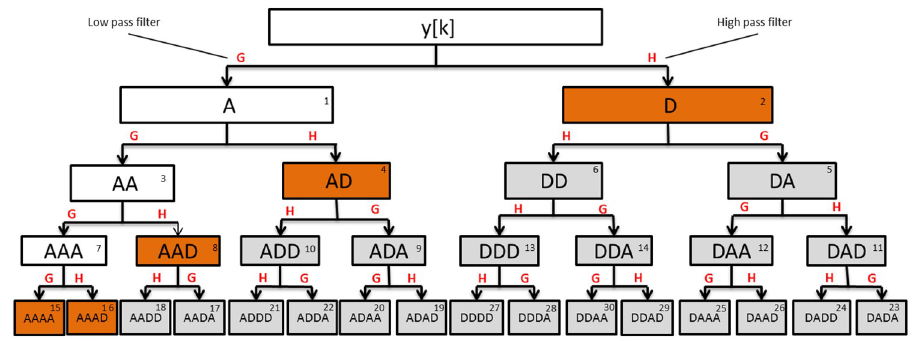
Fig 2. Schematic of MODWPT decomposition upto level 4. ‘A’ and ‘D’ refers to approximation and detail respectively. Integer in the top-right corner of each box indicates the packet number in increasing frequency order.